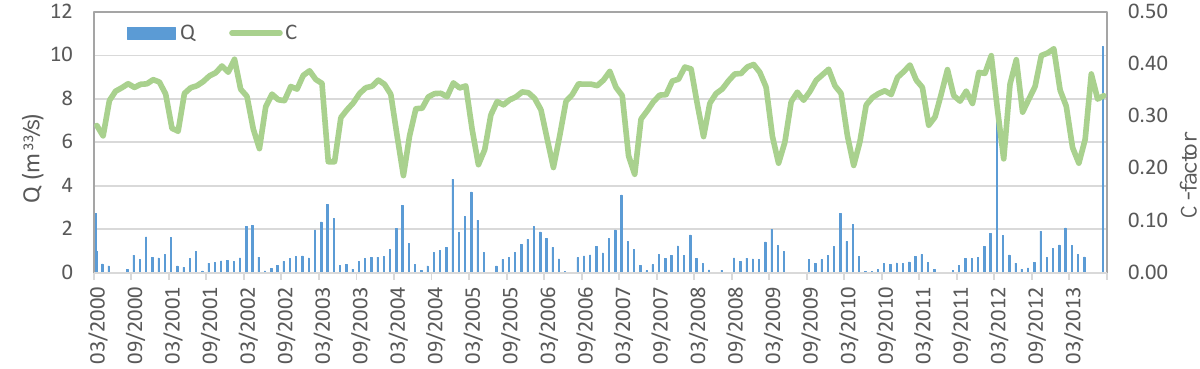
Figure 3. Monthly C-factor and flow discharge (Q) time series plot for Boostan Dam Watershed (2000–2013).